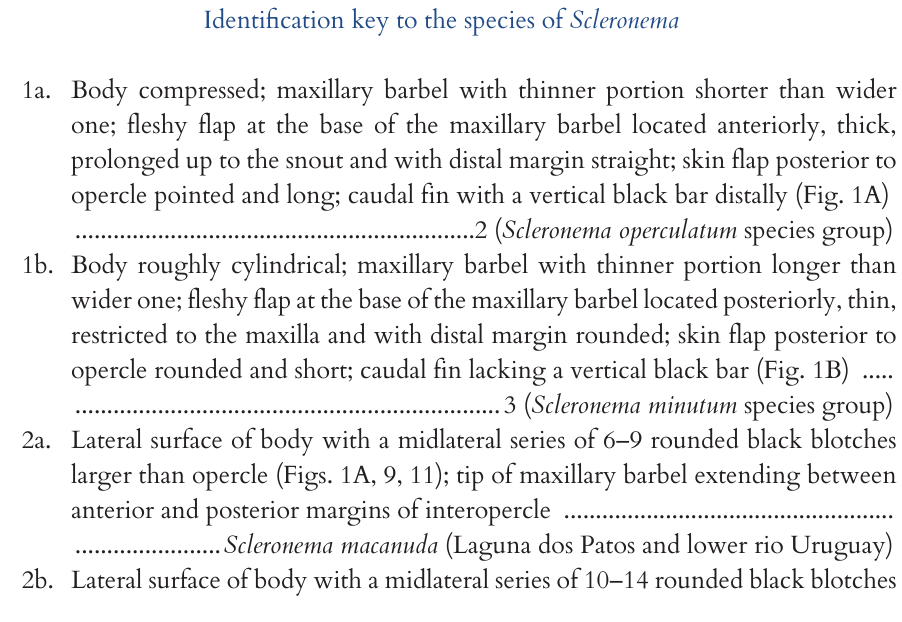
showing the arch-shaped process on its dorsal surface (black arrow). Scale bar = 2